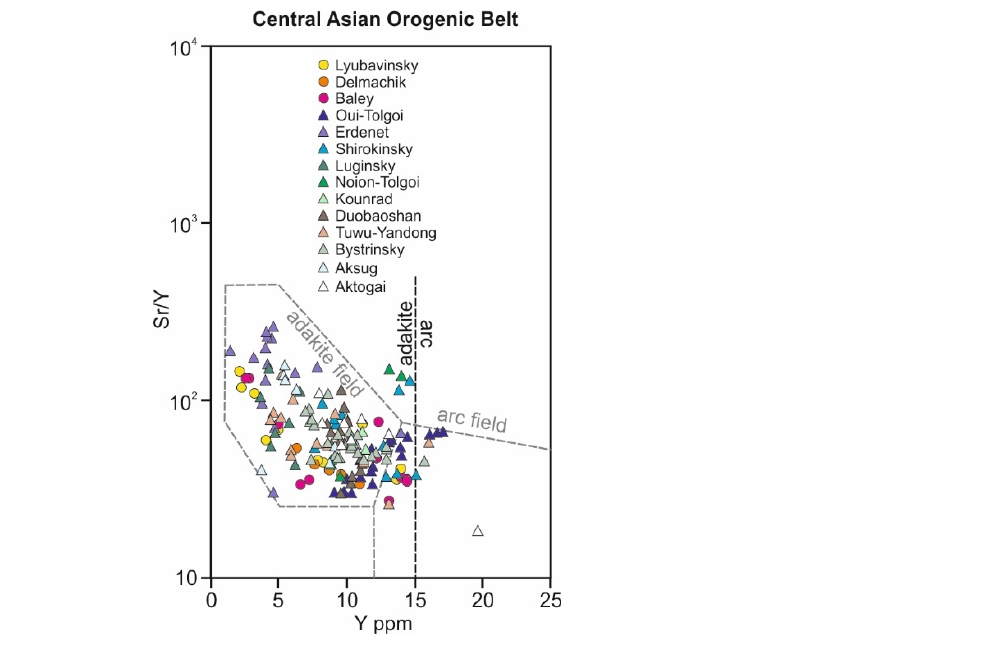
Figure 19. Variations of Sr/Y versus Y (ppm) in igneous rocks associated with porphyry Cu–Au–Mo (triangles) and epithermal Au–Ag (circles) deposits in the Central Asian Orogenic Belt. Data sources: